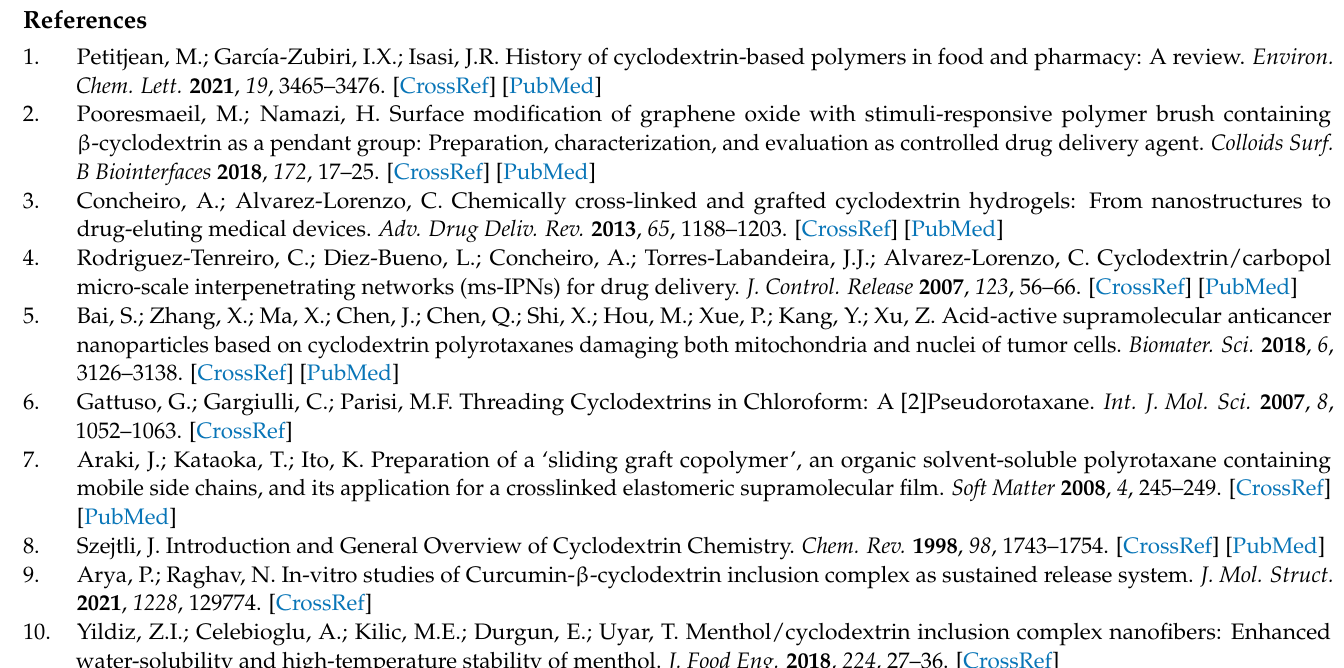
Figure S2, 1 H NMR spectra of curcumin in D 2 O and in DMSO-d 6 ; Figure S3, 1 H NMR spectra of 1 H NMR spectra of insoluble in β CPCD–curcumin mixture in D 2 O and in DMSO-d 6 ; Figure S4, Full D 2 O β CPCD–curcumin mixture registered in DMSO-d 6 ; Figure S5, 1 H NMR spectrum of β CPCD polymer in DMSO-d 6 with proposed chemical structure and assignments of protons; Figure S6, Full 2D NMR NOESY spectra in DMSO-d 6 of β CPCD–curcumin complex at 10.0–2.8 ppm; Figure S7, Concentration vs. time dissolution curves of hard gelatin capsules filled with curcumin–cyclodextrin polymer complexes (data are presented as means ± SD; n =